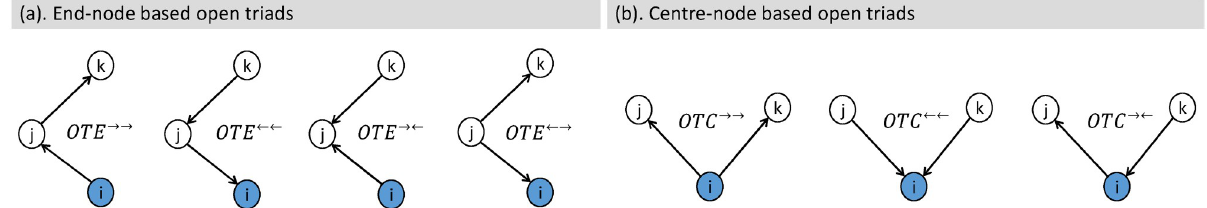
Fig 5. Two groups of directed open triads. (a). Four different open triads with the focal node i as the end-node. Two arrows on the superscript describe the directions of two edges: First arrow depicts an edge from i to j ( ! ) or from j to i ( ); second arrow depicts an edge from j to k ( ! ) or from k to j ( ). (b). Three different open triads with i as the centre-node. First arrow depicts the edge direction between i and j while second arrow depicts the edge direction between i and k . There are three instead of four since when the focal node is in the centre, node j and k are symmetric to it.